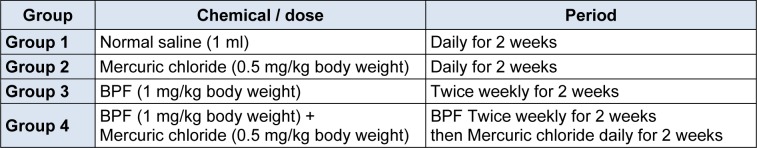
Experimental design